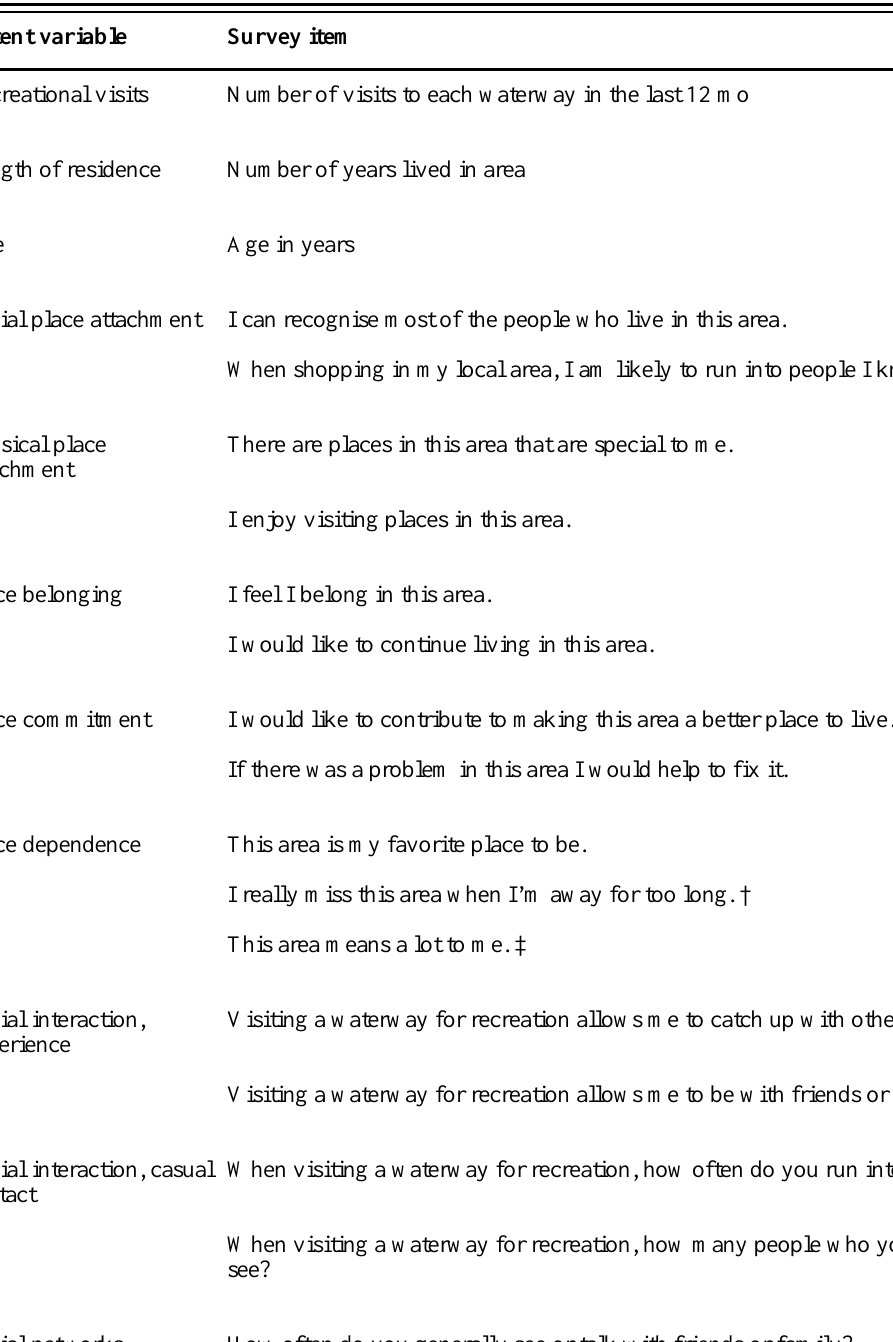
Table 2. Survey items and corresponding latent